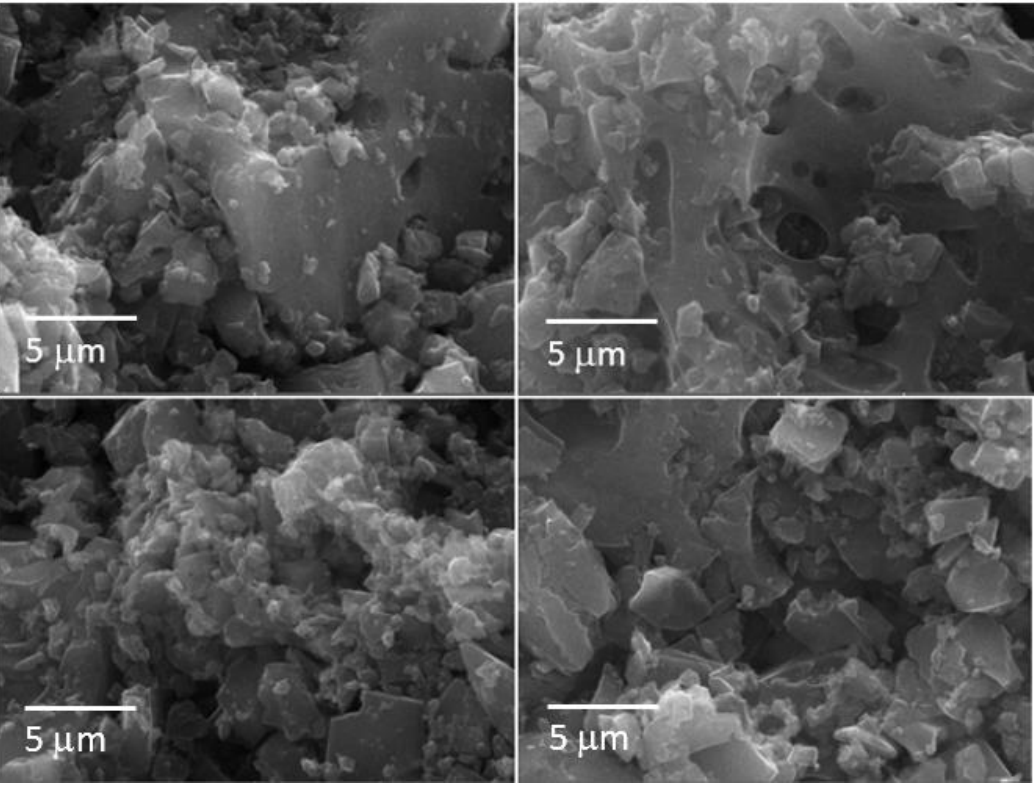
Figure 5. Morphology of the hard carbons after activation with KOH recorded at low magnification. Upper left : apricot kernel; ( upper right ): cherry stone. ( Lower left ): olive stone; ( lower right ): wal- nut shell.